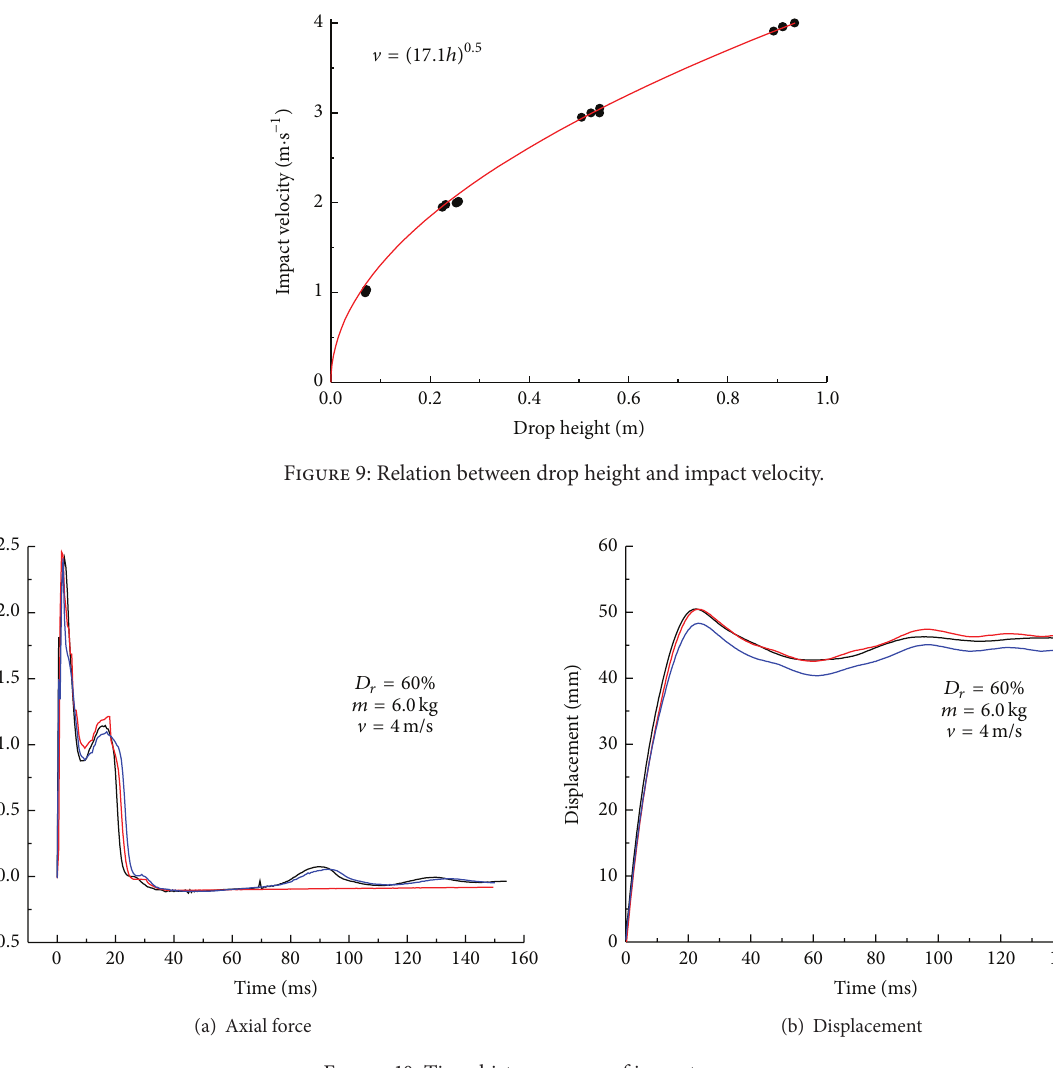
Figure 10: Time-history curves of impact response.